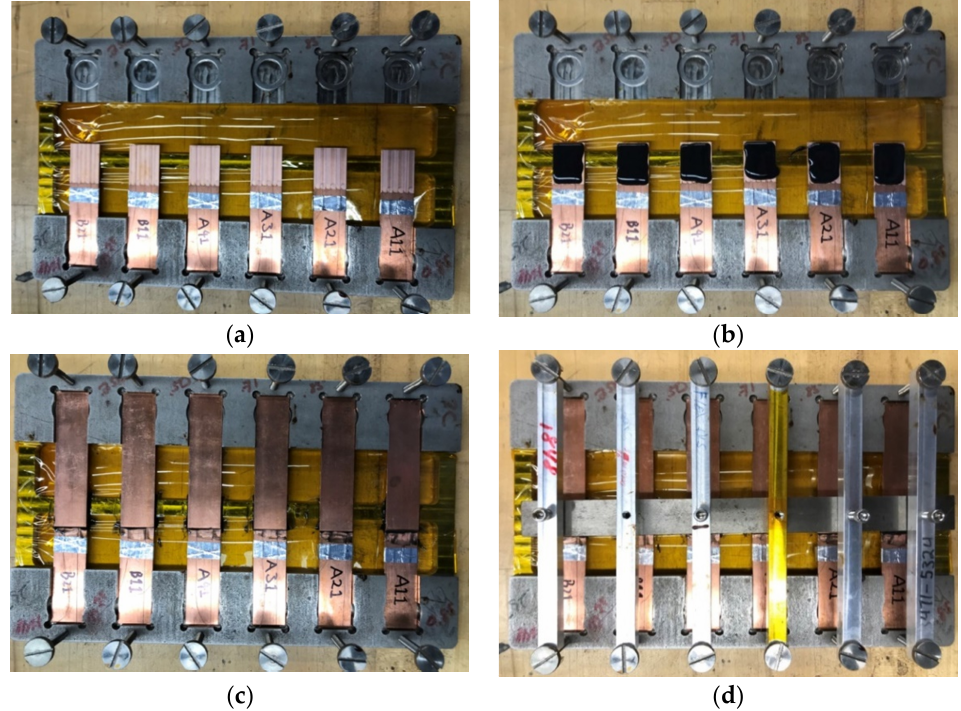
Figure 4. Photographs showing the single-lap shear join bonding process and fixture: ( a ) specimens placed on one side of the fixture; ( b ) adhesive applied on the bonding area; ( c ) specimens placed on the other side of the fixture; ( d ) tightened bolts pressed the two specimens firmly onto each other.